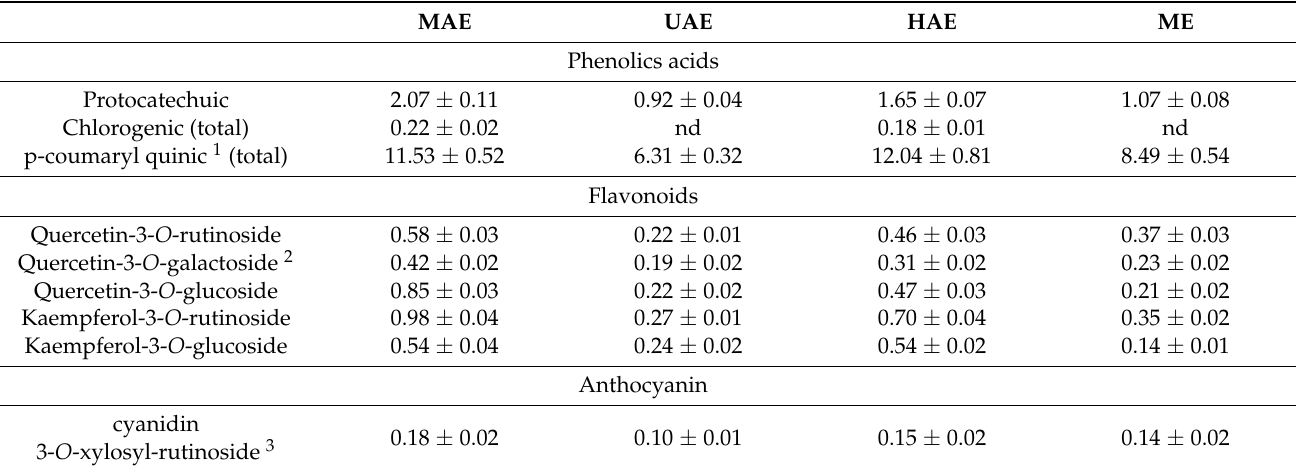
Table 3. The concentration of phenolic acids and flavonoids ( µ g/mL) in S. chinensis fruit extracts was obtained using microwave (MAE), ultrasound (UAE), heat extraction (HAE) and maceration with continuous stirring